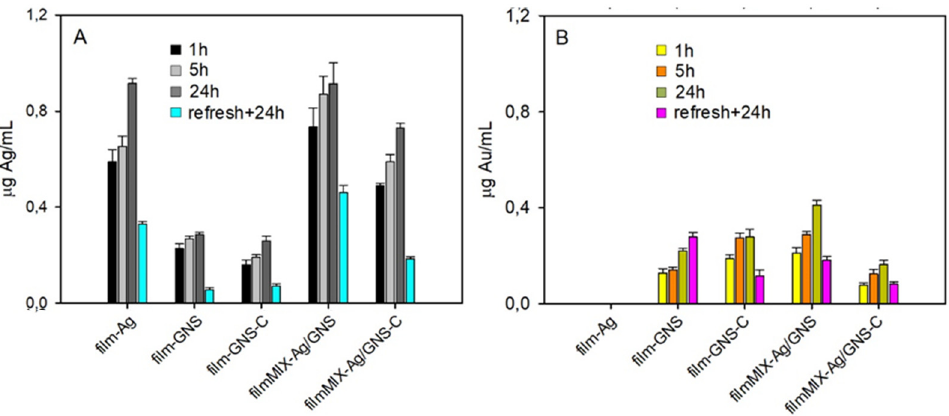
Figure 6. ( A ) Ag release (mg/mL) from 90 mg films fragments in 3.0 mL bidistilled water after 1, 5 and 24 h; ‘refresh +24 h’ data refer to films removed from water after 24 h and dipped in fresh bidistilled water for further 24 h and ( B ) same for Au.